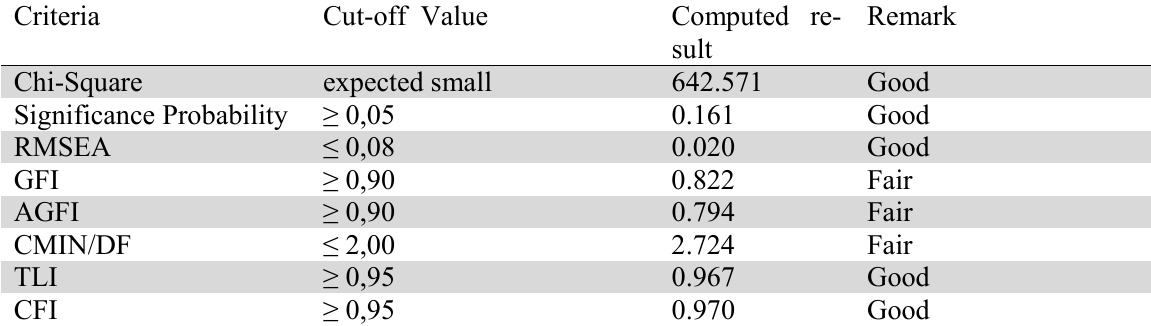
The Evaluation of Criteria of Goodness of Fit Indices Model One-Step Approach – Modification Criteria Cut-off Value Computed re- Remark